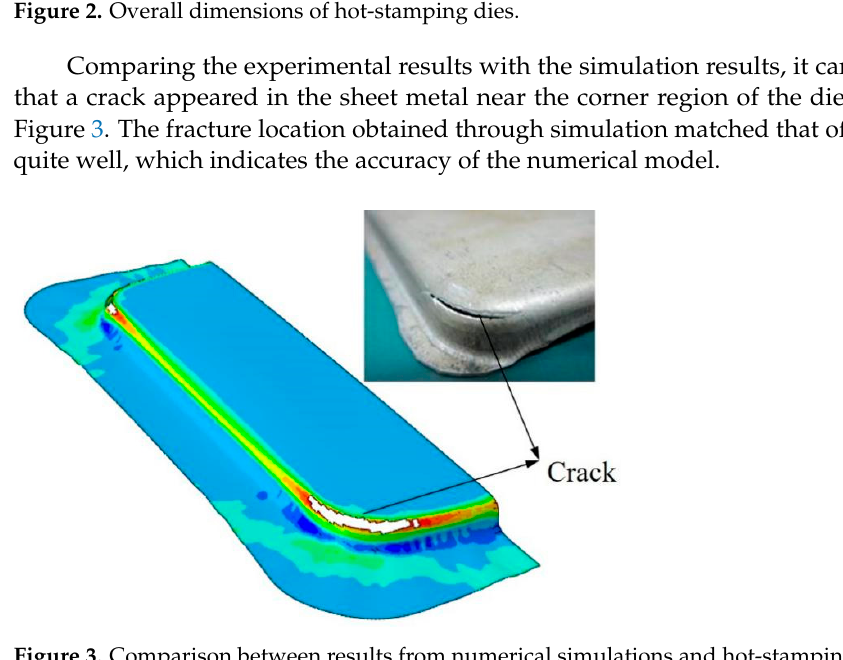
Figure 2. Overall dimensions of hot-stamping dies.